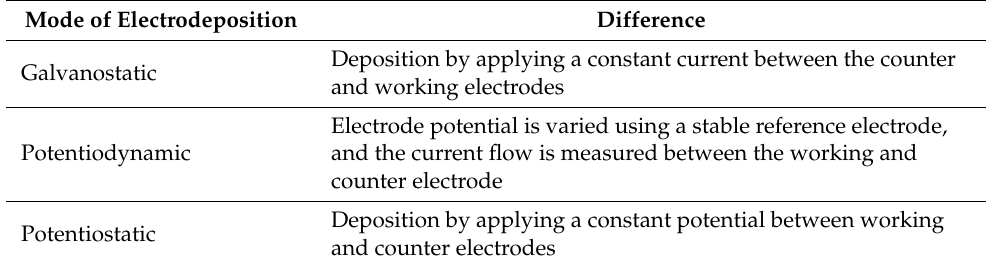
Table 1. Modes of